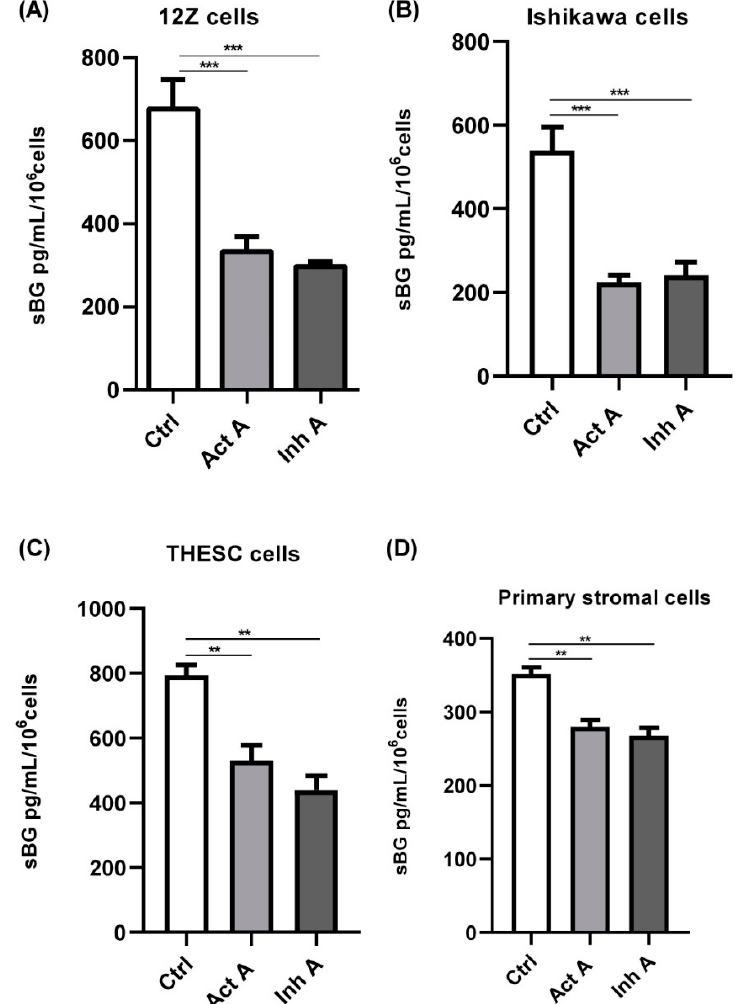
Figure 3. Activin A and inhibin A regulate BG shedding in different cell types. Endometriotic epithelial 12Z ( A ), endometrial epithelial Ishikawa ( B ), primary human endometrial stromal ( C ), and endometrial stromal THESC ( D ) cells were treated with activin A or inhibin A (25 ng/mL) for 48 h and supernatants were analyzed by sBG ELISAs. Both activin A and inhibin A significantly attenuated BG shedding in all four cell types. Untreated cells were used as controls (ctrl). Each bar represents the mean ± SEM of 3 independent experiments performed in duplicate. Dunnett’s test was used for statistical analysis; ** p < 0.01; *** p < 0.001; sBG, soluble betaglycan; Ctrl, control; Act A, activin A; Inh A, inhibin A.